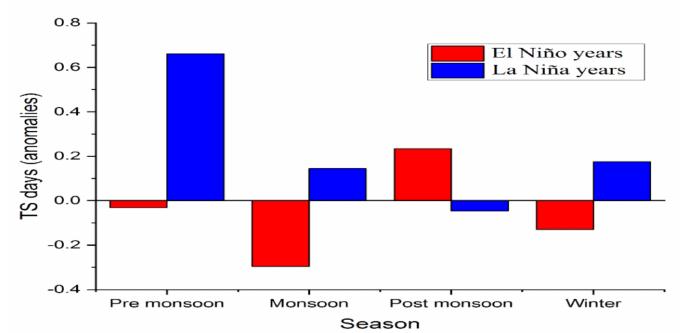
Figure 11. Same as Figure 10, but for composite anomalies of the average TS days during the El Niño (indicated as red color) and La Niña (blue) years.